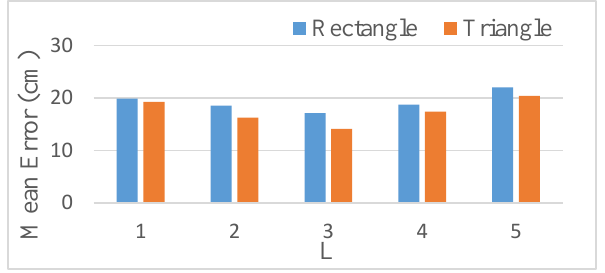
Figure. 5. The relationship between positioning accuracy and analysis window ( L ) size.